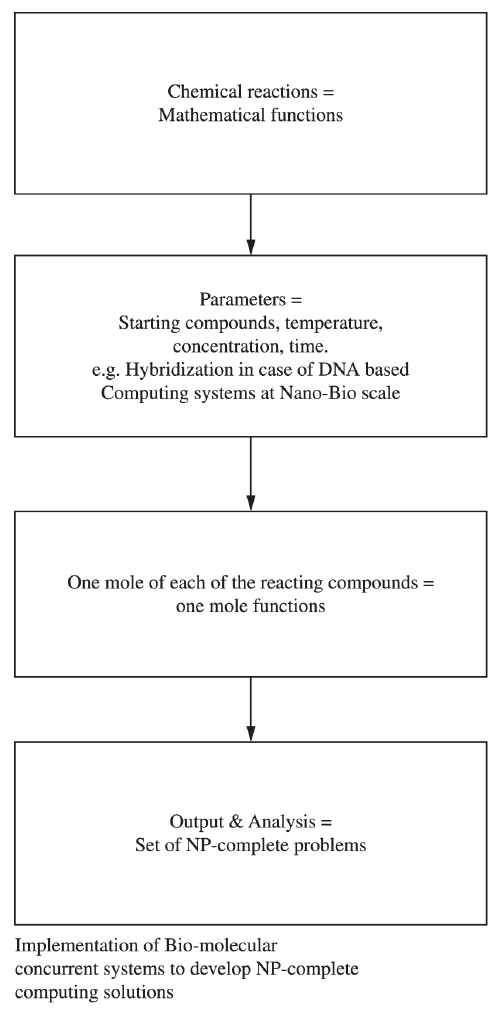
Figure 5. Implementation of concurrent systems and their algorithm